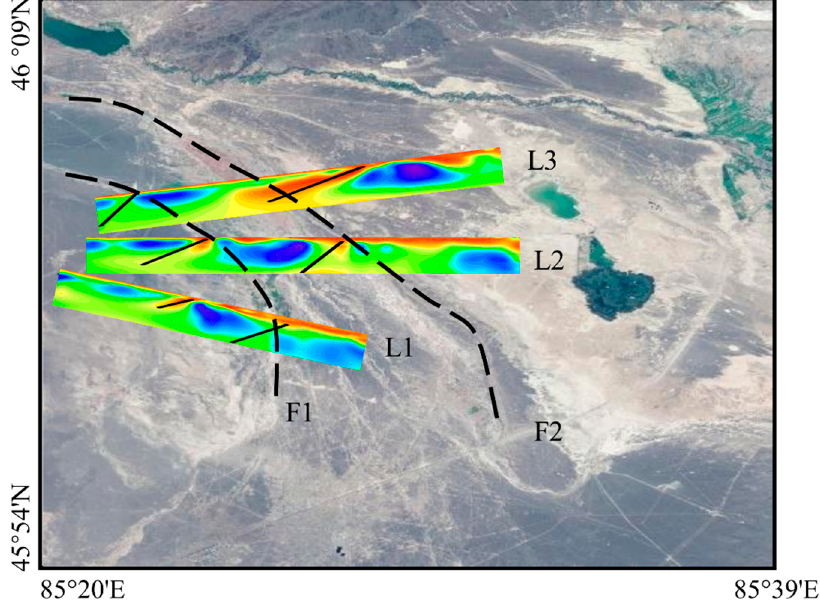
Figure 12. Model of MT inversion of the electrical structure for profiles L1–3.